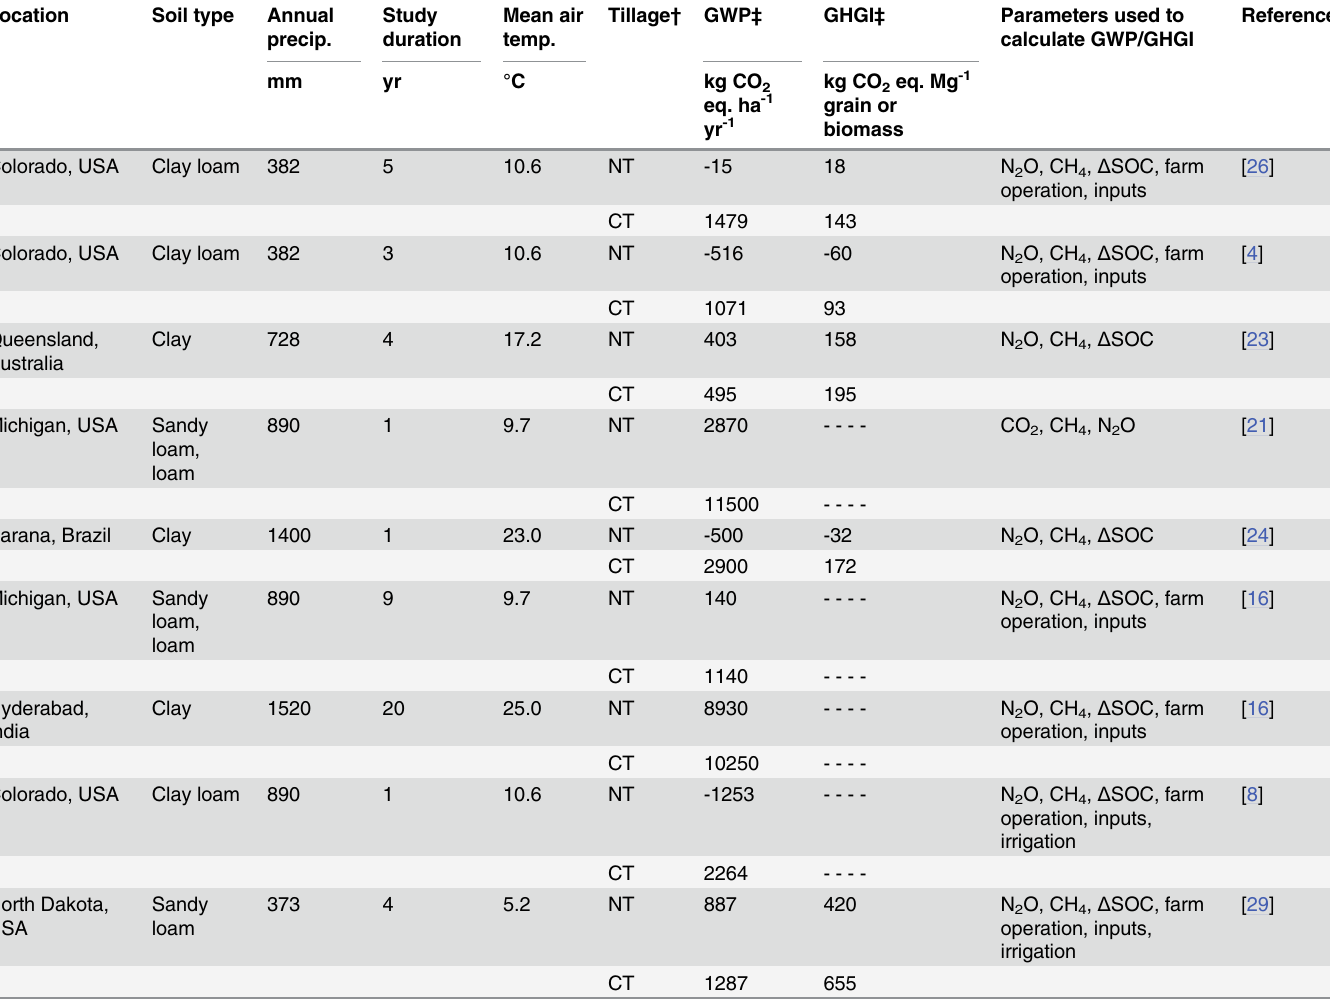
Table 1. Effect of tillage on net global warming potential (GWP) and greenhouse gas intensity (GHGI) calculated by using the soil organic C method in various regions with different soil and climatic conditions. Location Soil type Annual